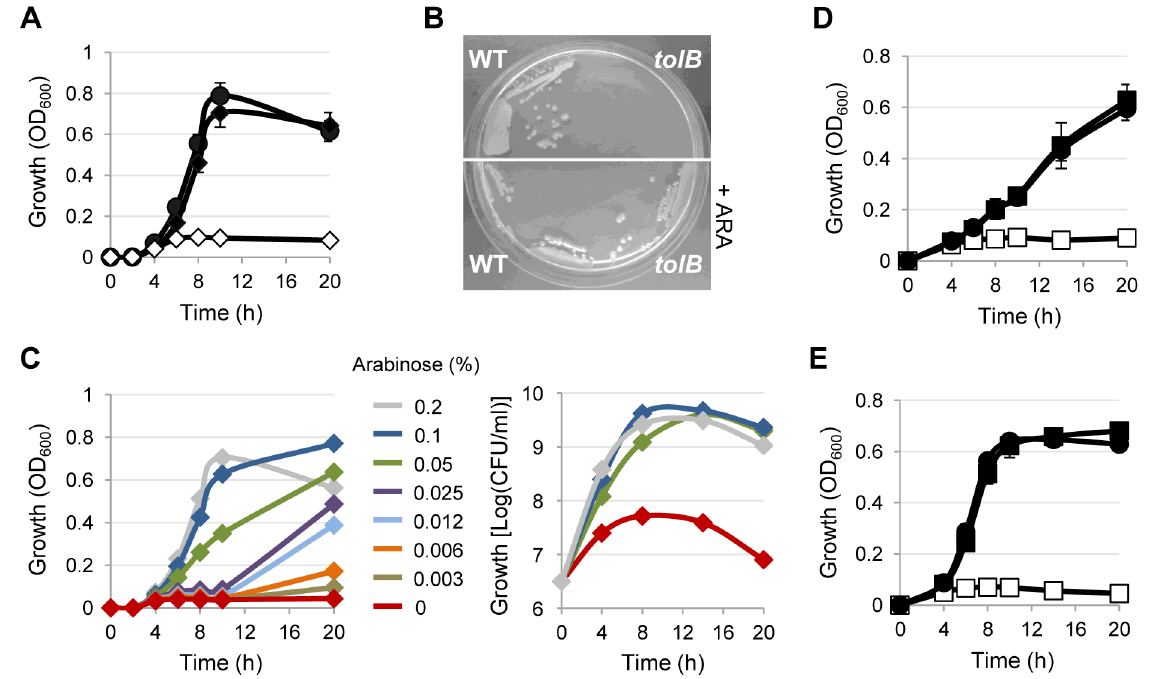
Figure 2. TolB is essential for P.aeruginosa growth invitro . (A) Growth curves of the wild-type strain PAO1 (filled circles) and the PAO1 tolB conditional mutant in the presence (filled diamonds) or in the absence (open diamonds) of 0.2% arabinose in MH broth at 37 u C in microtiter plates at 200 rpm. Results are the mean ( 6 SD) of three independent experiments performed in triplicate. (B) Growth of PAO1 and the PAO1 tolB conditional mutant on MH agar plates with or without 0.2% arabinose (ARA) at 16 h. (C) Growth of the PAO1 tolB conditional mutant as described in legend to panel A in the presence of increasing concentrations of arabinose (0–0.2%), measured as OD 600 (left panel) or CFU/ml (right panel). The graphs are representative of at least two independent experiments giving similar results. (D) Growth curves of P. aeruginosa PA14 or (E) the clinical strain TR1 (filled circles) and their corresponding tolB conditional mutants in the presence (filled squares) or in the absence (open squares) of 0.2% arabinose in MH broth at 37 u C in microtiter plates at 200 rpm. Results are the mean ( 6 SD) of two independent experiments performed in triplicate.